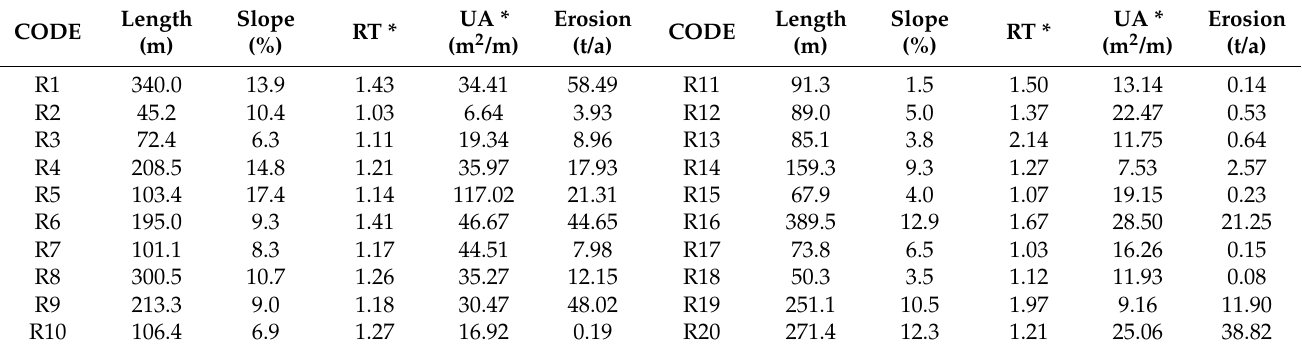
Table 1. Terrain factors and the TLS-measured erosion for each road segment.